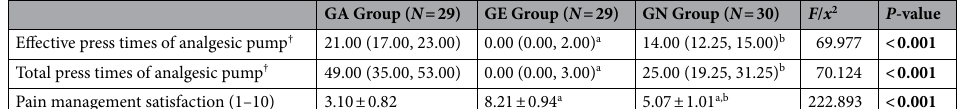
GA Group ( N = 29) GE Group ( N = 29) GN Group ( N = 30)